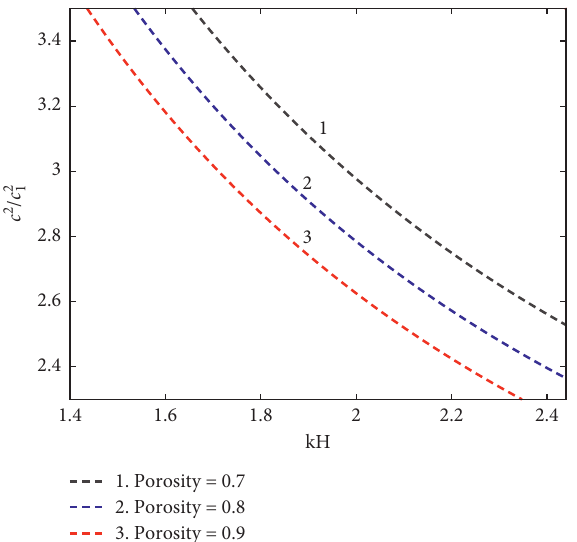
Figure 9: Model-II: effect of the heterogeneity parameters ( α / k ) under soft mountain surface.